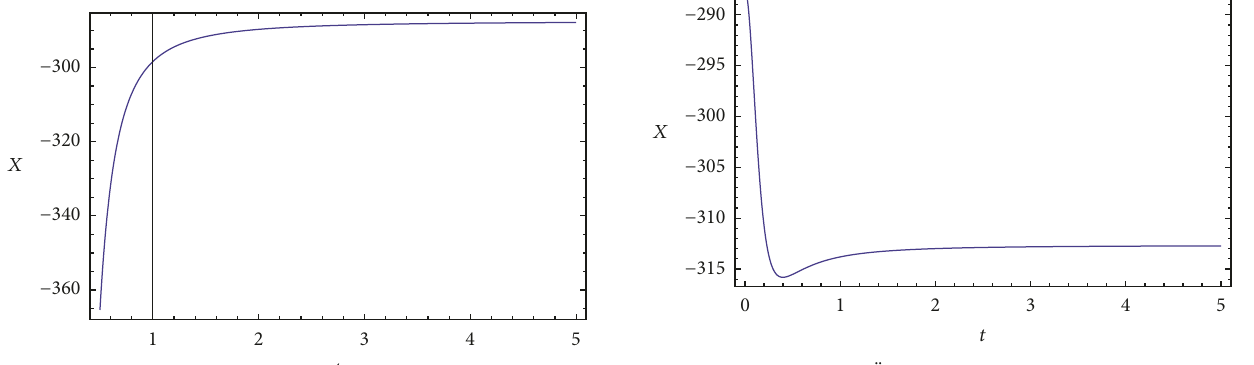
̈𝑆 Figure 14: Plot of 𝑋 = tot by taking Renyi entropy as entropy at event